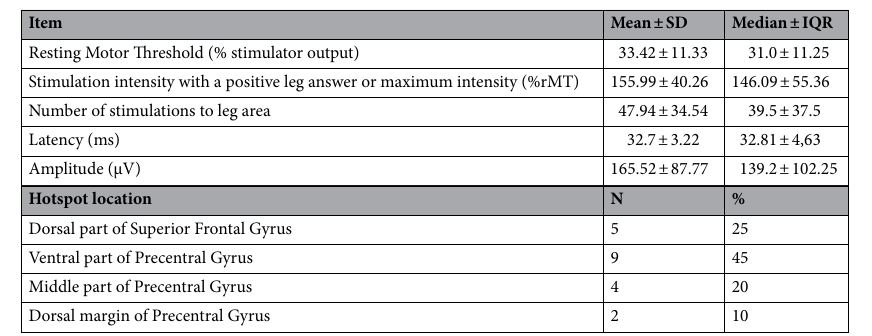
Table 3. Overview of nTMS stimulation parameters of the whole cohort, latencies, amplitudes and hotspot location are displayed for patients with reproducible MEPs from the TA muscle.